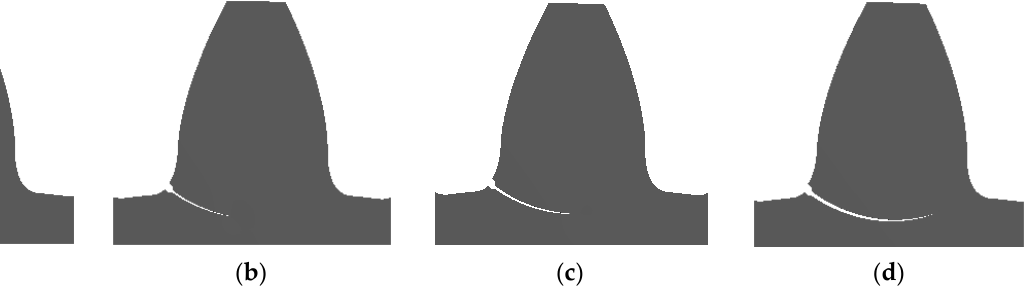
Figure 2. An illustration regarding the identi fi cation of di ff erent crack levels identi fi ed within the present study: ( a ) 25%; ( b ) 50%; ( c ) 75%; ( d ) 100% crack